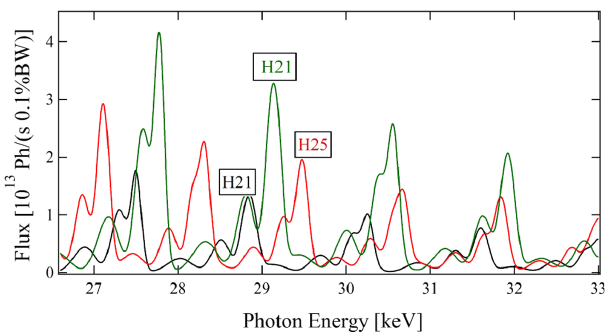
FIG. 4. Spectra calculated (using SRW) with beam and un- dulator parameters of Fig. 3. (Green) U18 Pr 2 Fe 14 B cryogenic undulator at 77 K, with K ¼ 1 . 937 . (Red) U20 Nd 2 Fe 14 B in-vacuum undulator at 293 K with K ¼ 1 . 967 . (Black) U20 Sm 2 Co 17 in-vacuum undulator at 293 K K ¼ 1 . 812 . H